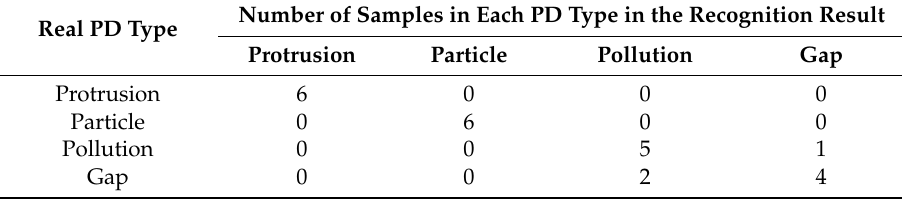
Table 8. Confusion matrix of the recognition